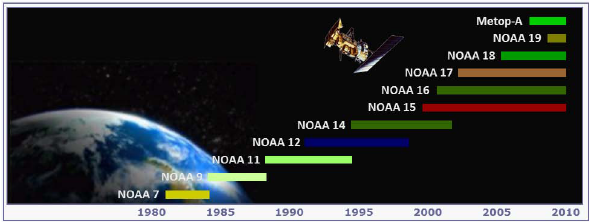
Fig. 1. Visualization of the NOAA satellites used in CLARA-A1. The NOAA satellite numbers (ordinate) are shown as a function of length of observational period (abcissa). Notice that number 20 denotes Metop-A. Some data gaps are present but only for isolated months for NOAA-7, NOAA-9, NOAA-12 and NOAA-14.